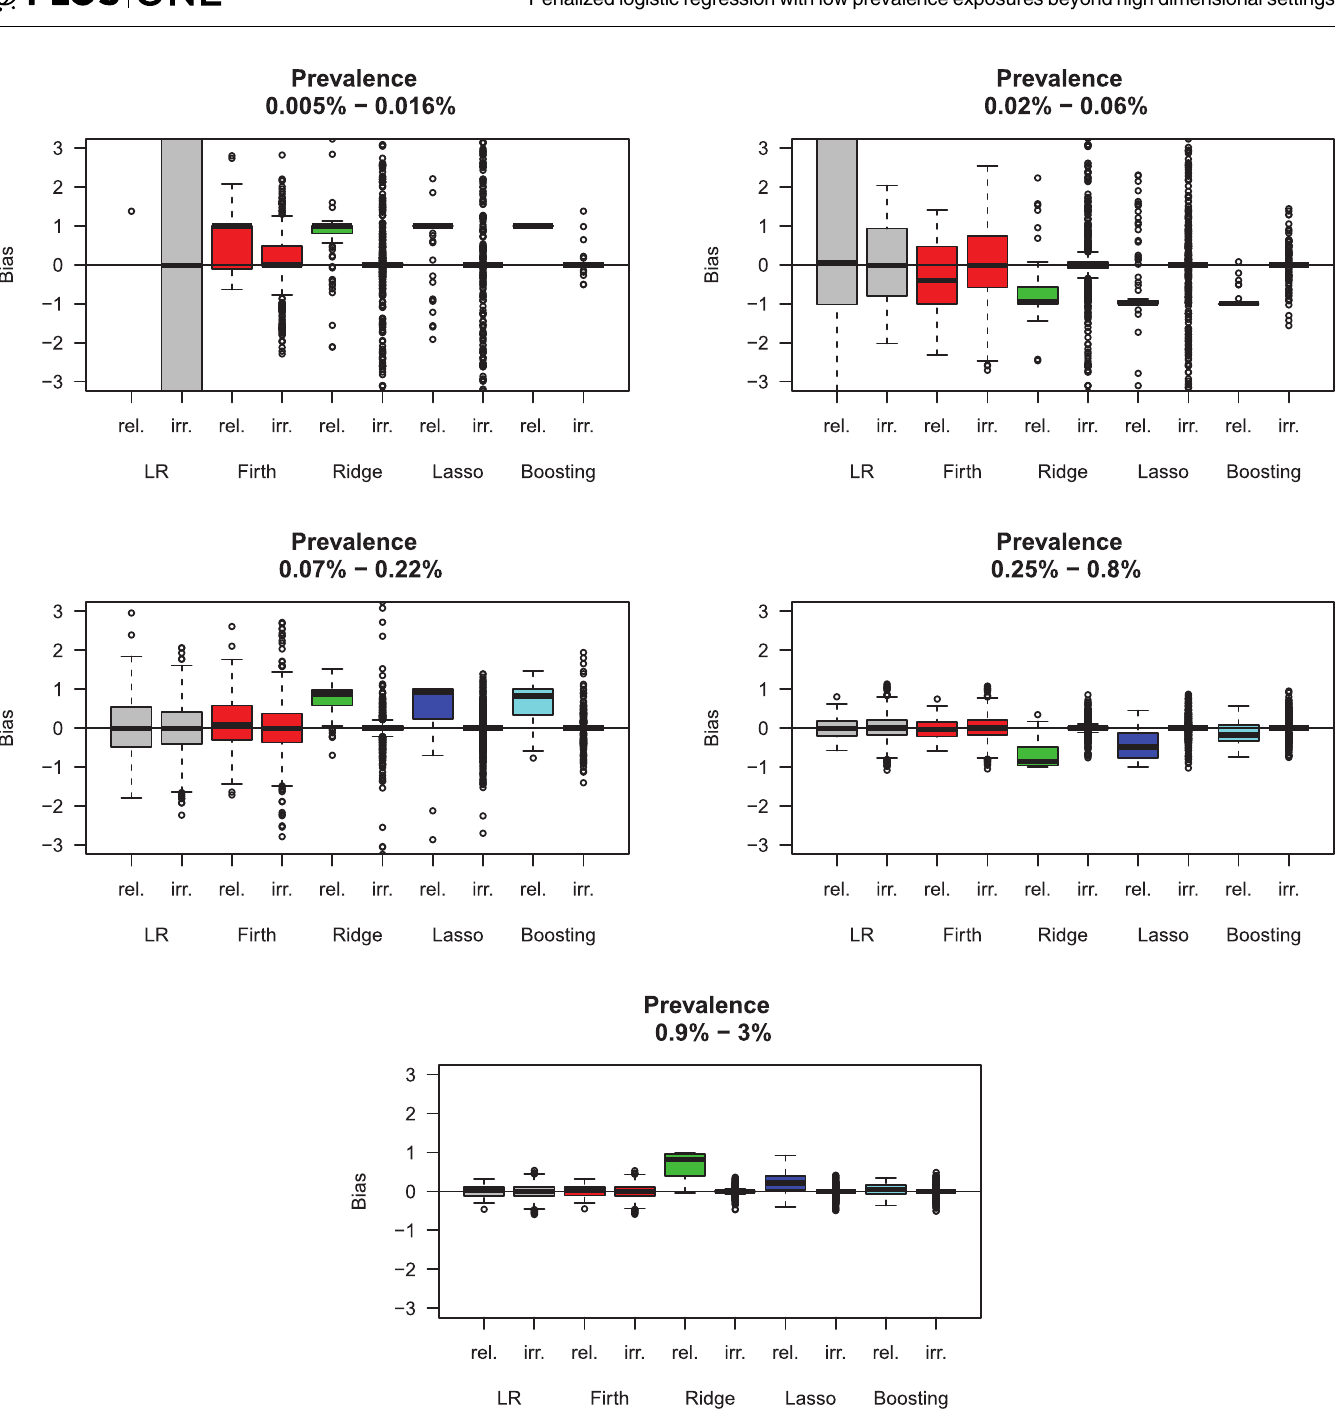
Fig 2. Simulation data. Each plot shows the bias for 1 relevant variable (rel.) and the 9 irrelevant variables (irr.) within the prevalence range. The boxplots are thus based on 100 values (one for each simulation study) for the relevant variables and 900 values (100 � 9) for the irrelevant